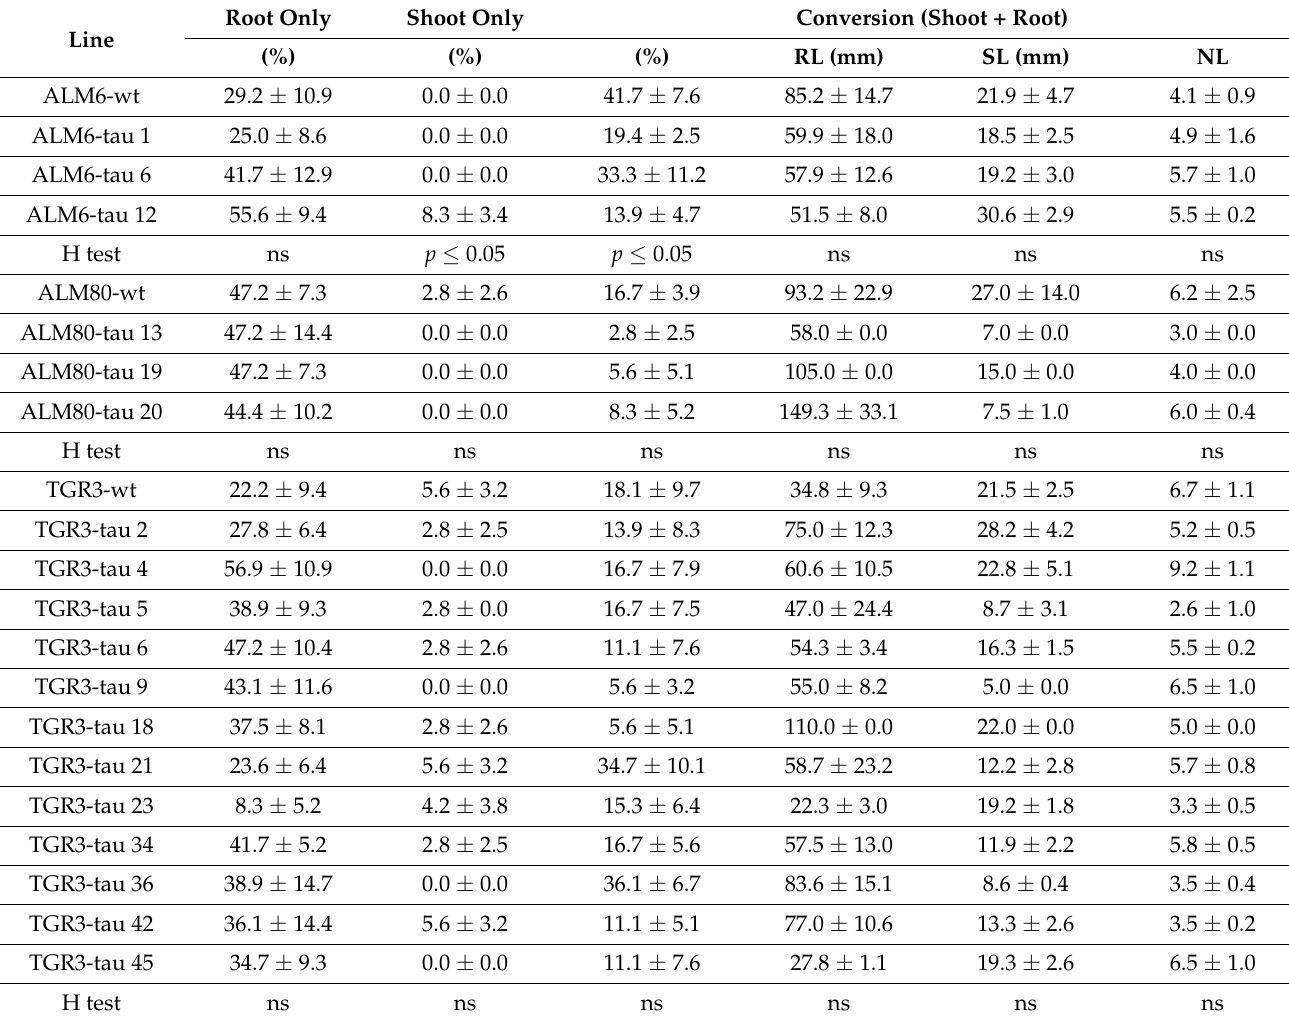
were obtained with the ALM80-tau 20 line (86.7%) and the non-transgenic line (75.0%). Finally, in genotype TGR3, rooting rates were also significantly influenced ( p ≤ 0.05) by the line, with the highest values observed in lines TGR3-tau 21 and TGR3-tau 6 (98.3% and 91.7%, respectively), while the rooting percentage was lowest in the non-transgenic line (76.7%) (Table 3). The number of roots per shoot varied between genotypes and lines, and it was higher in TGR3 transgenic lines (4.7–5.6) than in ALM6 transgenic lines (2.3–4.6) and ALM80 transgenic lines (1.6–2.4) (Table 3). Table 2. Germination response with root only development, shoot only development and conversion into plantlets (root and shoot development) of cork oak somatic embryos from transgenic and non-transgenic (wt) lines after 2 months of cold storage and 8 weeks on germination